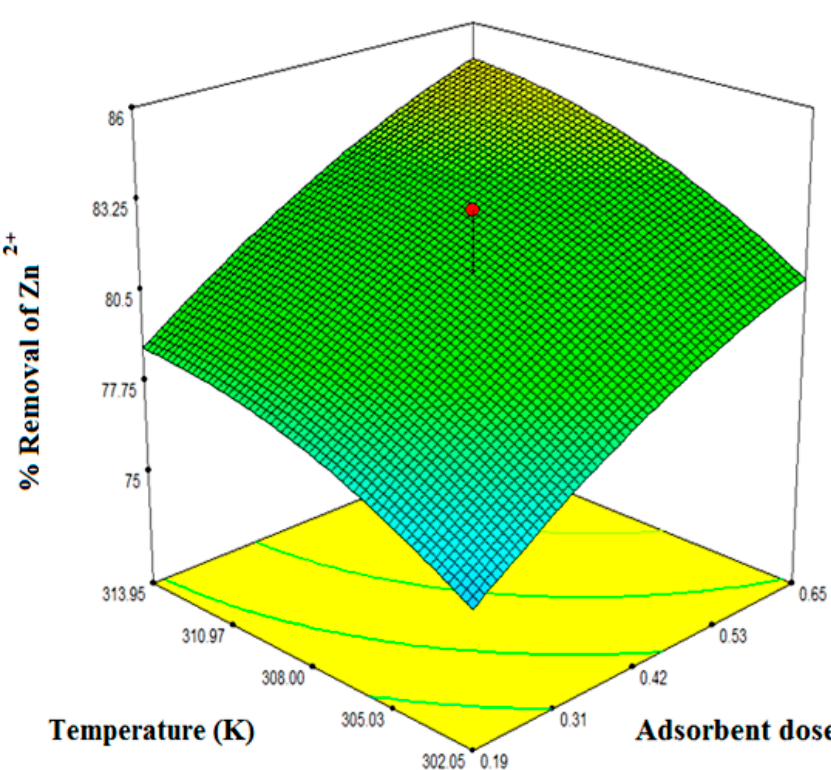
Figure 7. Interacting effects of temperature and adsorbent dose at an initial concentration of 42.13 mg/L.